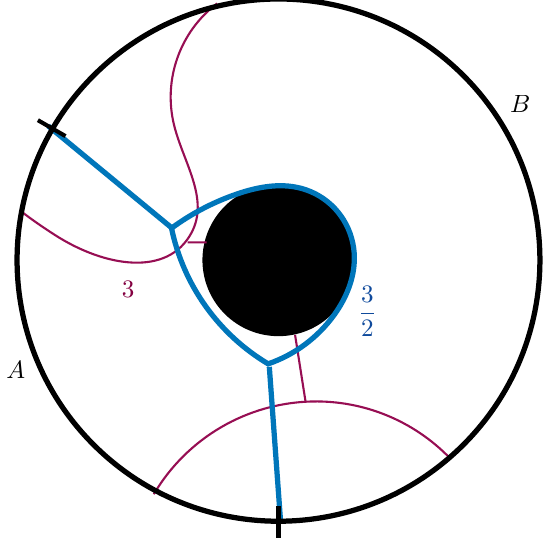
Figure 9 . The minimal barrier configuration for (3.17) applied to a black hole state with k = 3 . The solution is found using the double bubble conjecture with the black hole horizon (or equivalently the purifying boundary region O ) acting as the third region. Generically the minimal barrier configuration will deform such that it is not commensurate with the black hole horizon. Shown are examples of potentially contributing 3-threads which connect to the horizon, A and B